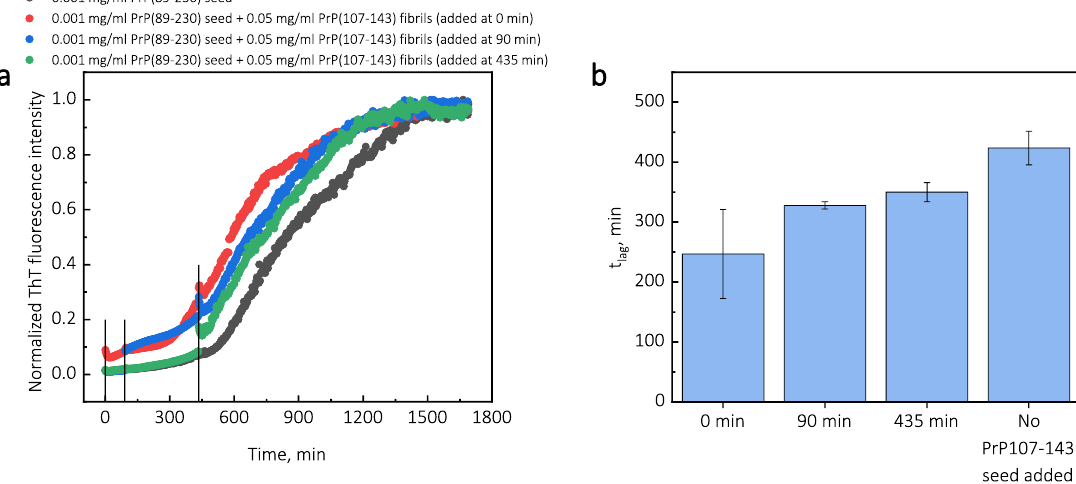
Figure A3. Average kinetic curves ( a ) and t lag values ( b ) of PrP(89-230) self-replication reaction performed with introduction of PrP(107-143) seed at different time-points of the reaction. Then, 10 µ L of 0.5 mg/mL PrP(107-143) fibrils were added to 100 µ L of PrP(89-230) solution (0.5 mg/mL of monomeric PrP(89-230) and 0.001 mg/mL PrP(89-230) fibrils) at a different time-points. The reaction kinetics were monitored by measuring ThT fluorescence intensity (ex. 440 nm; em. 480 nm) at 60 ◦ C through a bottom of non-biding 96-well plate (Corning No. 3881, New York, United States) using ClarioStar Plus (BMG Labtech, Ortenberg, Germany) microplate reader. The measurements were performed every three minutes. The error bars are standard deviations estimated from 3